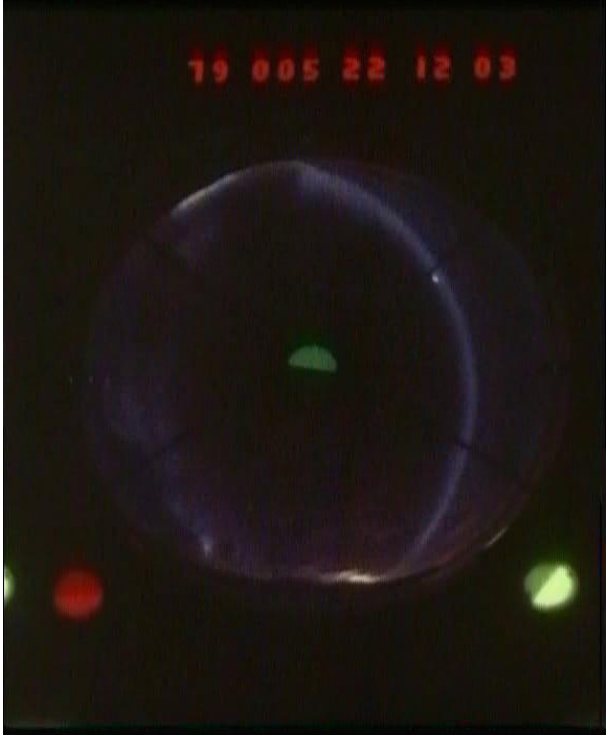
Figure 4. Image A: a high-quality image with human-readable dig- its at the top of the image. Prediction for the numbers in the clock display: 79 005 22 12. The bright round objects in the lower left and right corners and in the middle of the image are calibration